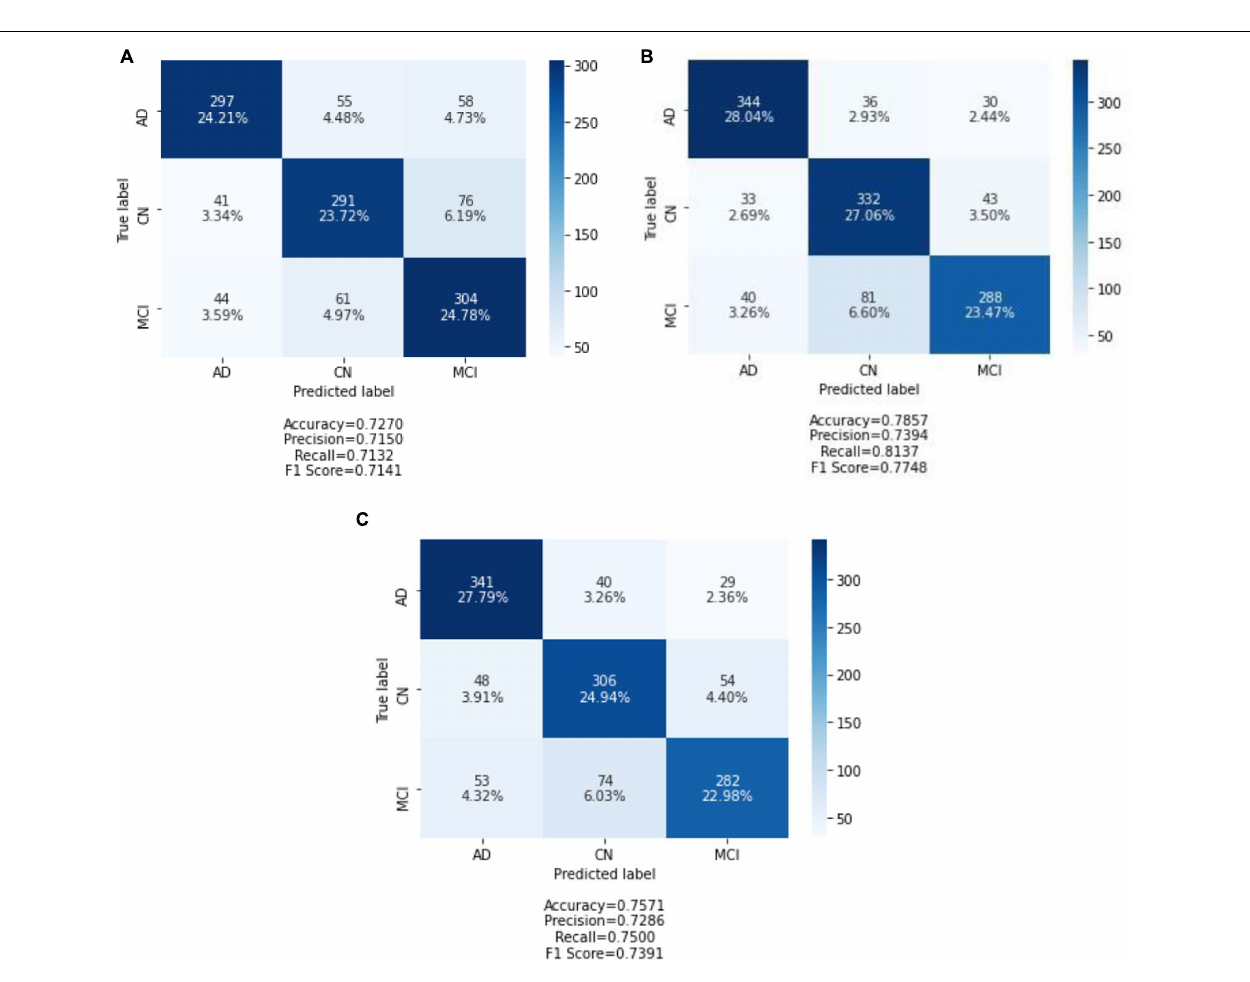
FIGURE 4 | Confusion matrix of three models on test data: (A) CNN from scratch; (B) VGG-16; and (C) ResNet-50. Each of the confusion matrices is visualized as a color-coded heat map using the seaborne library. It can be observed that all the plotted confusion matrices have darker cells for the diagonal elements. This indicates that more data are being predicted correctly to their respective label. Conversely, the off-diagonal elements with light shades indicate misclassifications done by the